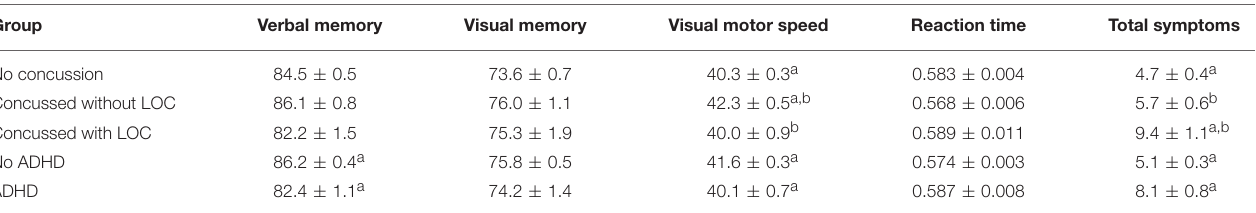
TABLE 1 | Means ( ± SE) for ImPACT composite scores and total symptoms for concussion history and ADHD.